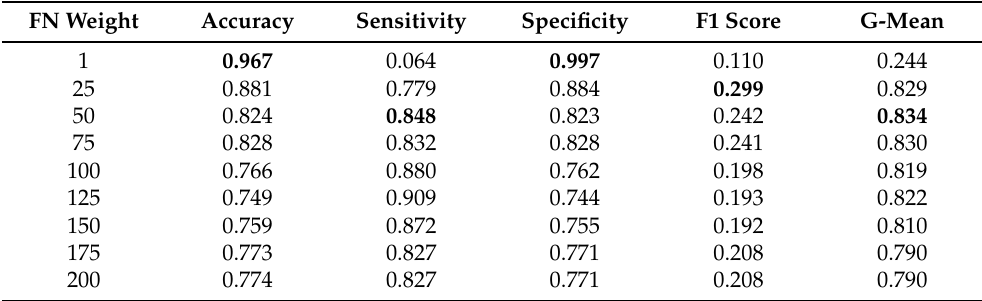
Table 4. The effects of the weight of false negative predictions on all metrics using the PSO (for the dataset of Taiwanese companies). The best result for each metric is marked in